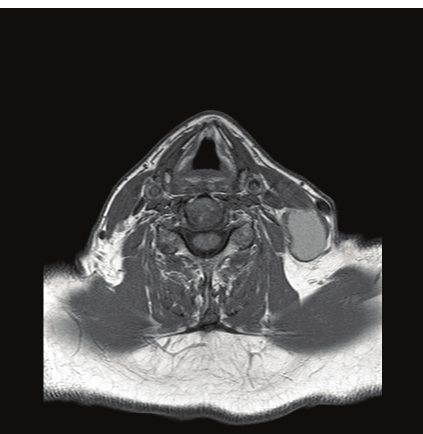
Figure 1: Axial slides of T1-weighted MRI showing a hyperintense cystic lesion behind the left sternocleidomastoid muscle in the neck level five.